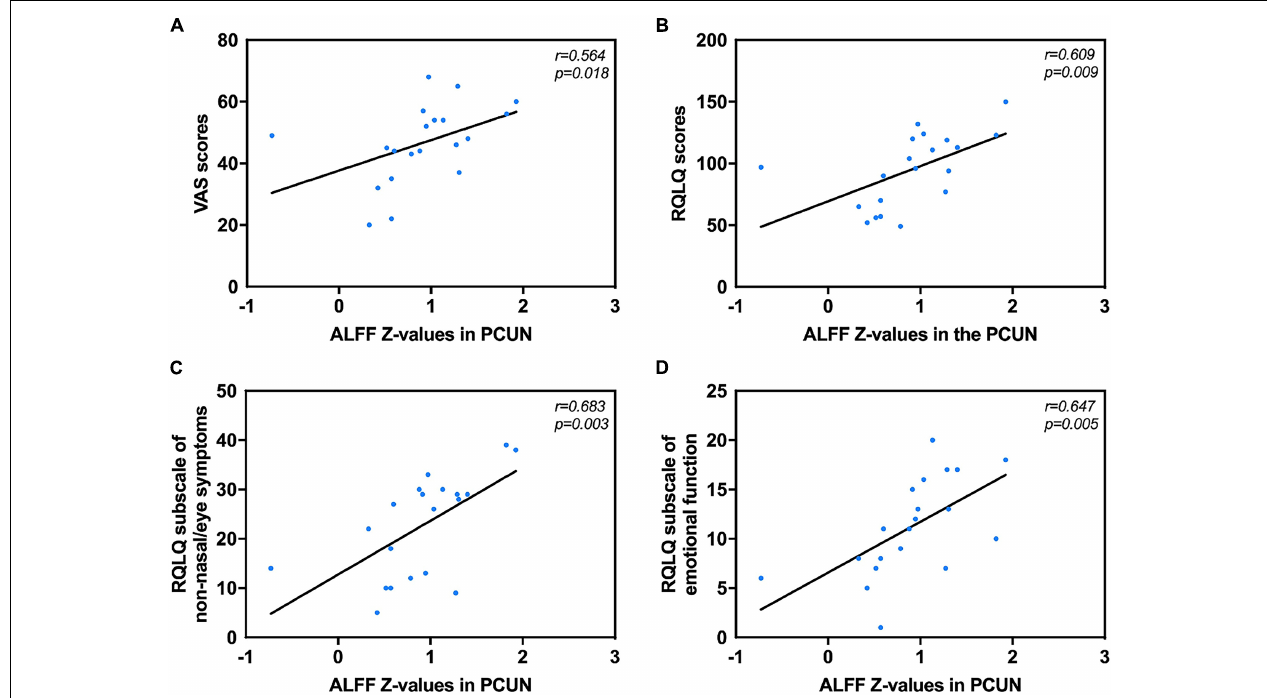
FIGURE 3 | Significant correlation analyses between AR patients’ ALFF values in the PCUN and clinical indexes. (A) PCUN and VAS scores: n = 20, r = 0.564, p = 0.018. (B) PCUN and RQLQ scores: n = 20, r = 0.609, p = 0.009. (C) PCUN and subscale of non-nasal/eye symptoms of RQLQ scores: n = 20, r = 0.683, p = 0.003. (D) PCUN and subscale of emotion symptoms of RQLQ scores: n = 20, r = 0.647, p = 0.005. ALFF, amplitude of low-frequency fluctuation; AR, allergic rhinitis; PCUN, precuneus; VAS, visual analog scale; RQLQ, Rhinoconjunctivitis Quality of Life Questionnaire.